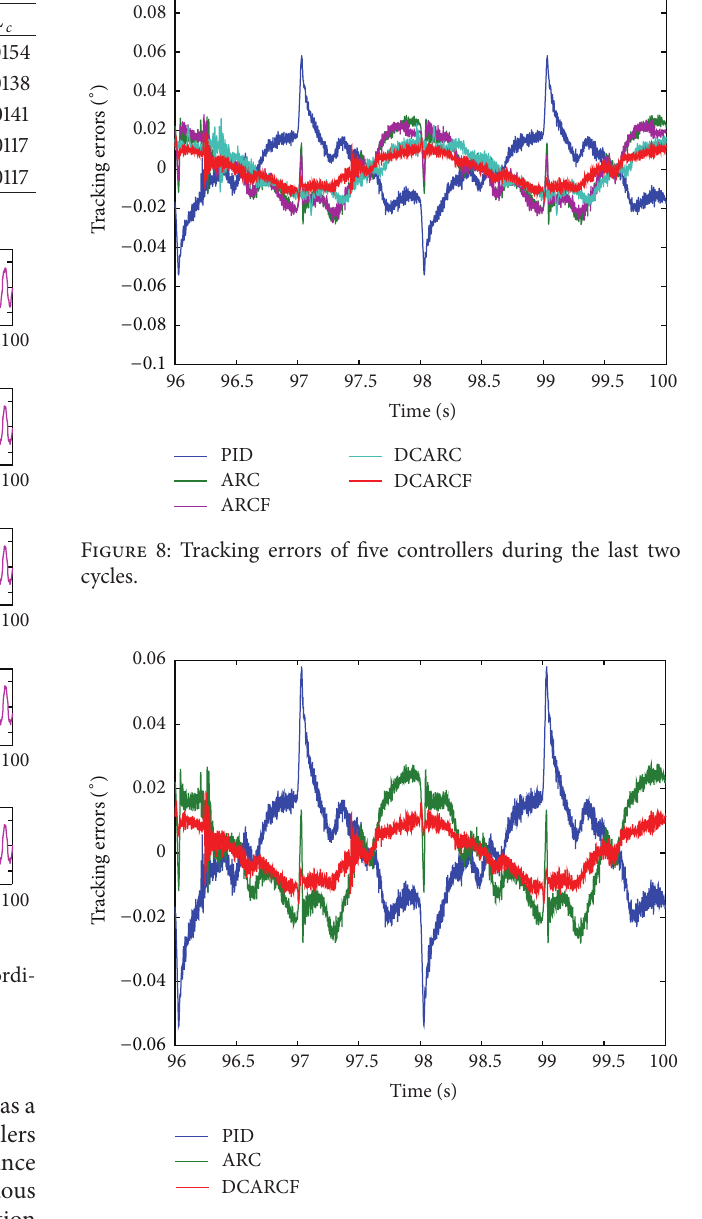
Figure 9: Tracking errors of three controllers during the last two